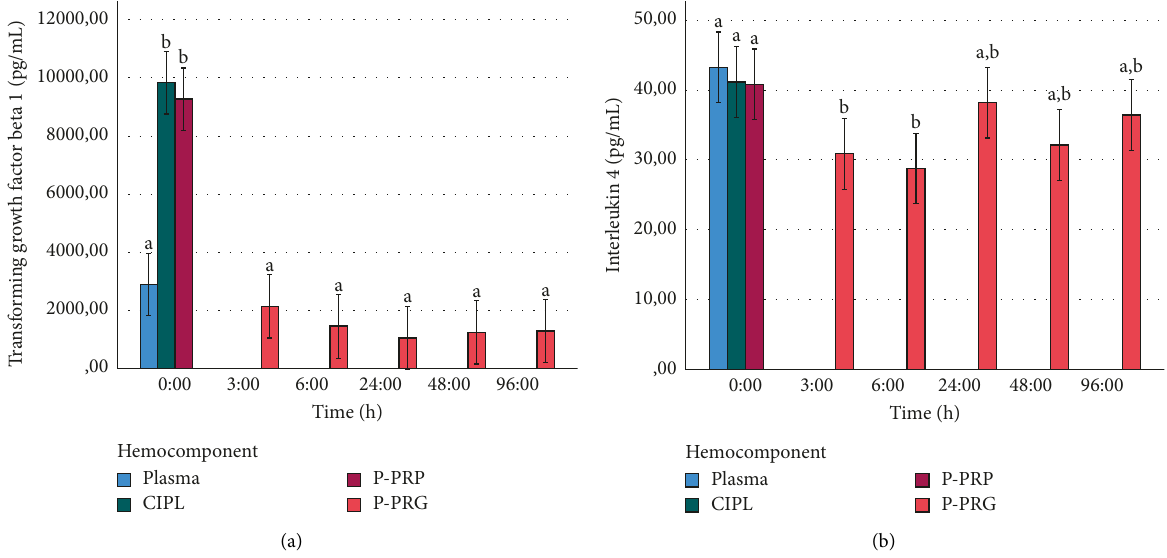
Figure 8: Mean ± sd temporal release of transforming growth factor b 1 (a) and interleukin 4 (b) concentrations from P-PRGs to culture media. a–c Different lowercase letters denote significant ( P < 0 . 001) differences over the time by the Games–Howell post hoc test.